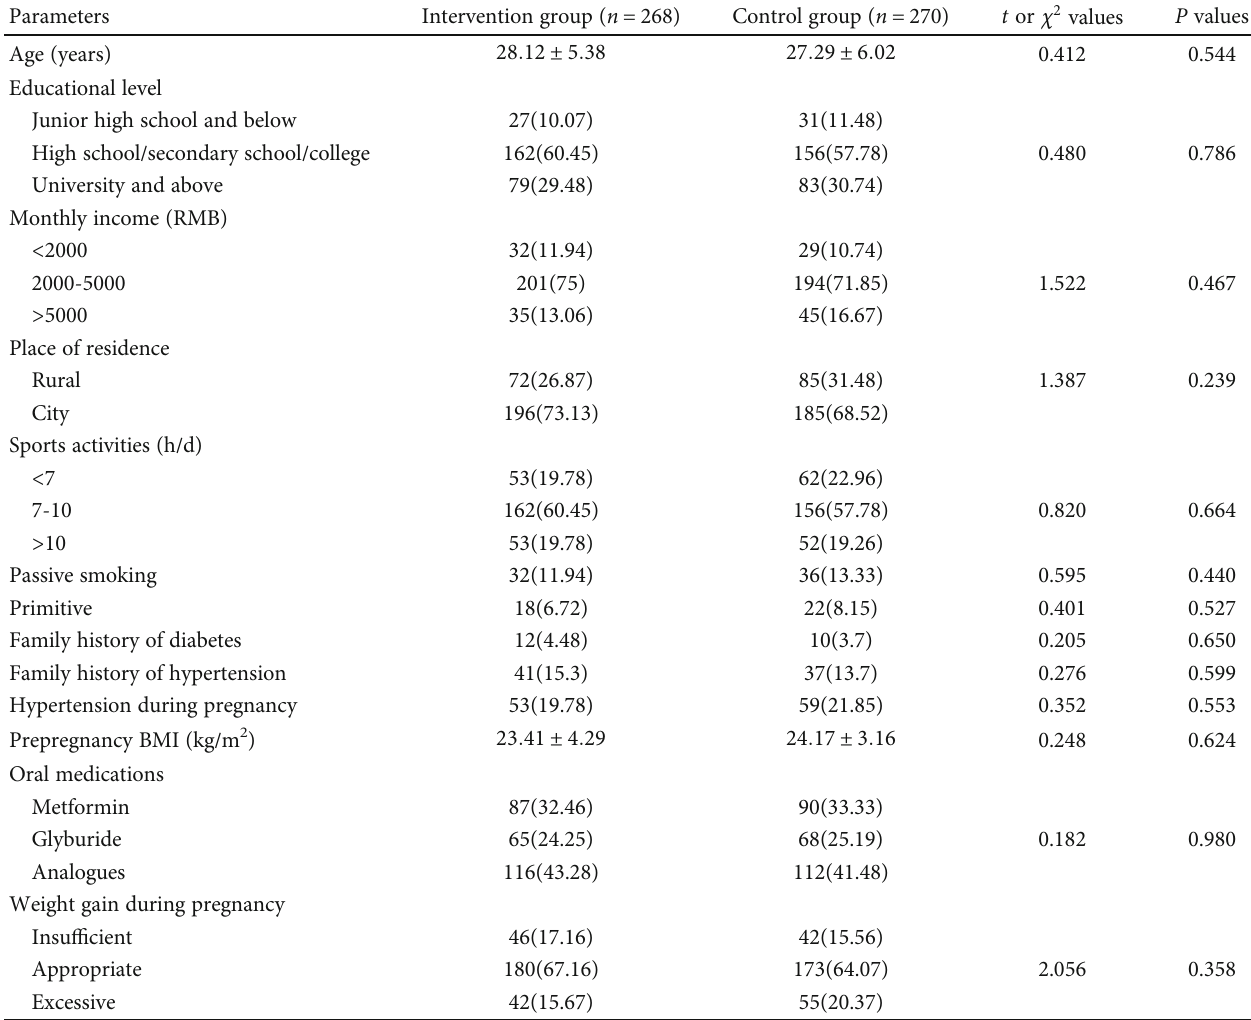
Table 4: Baseline characteristics between two groups, n